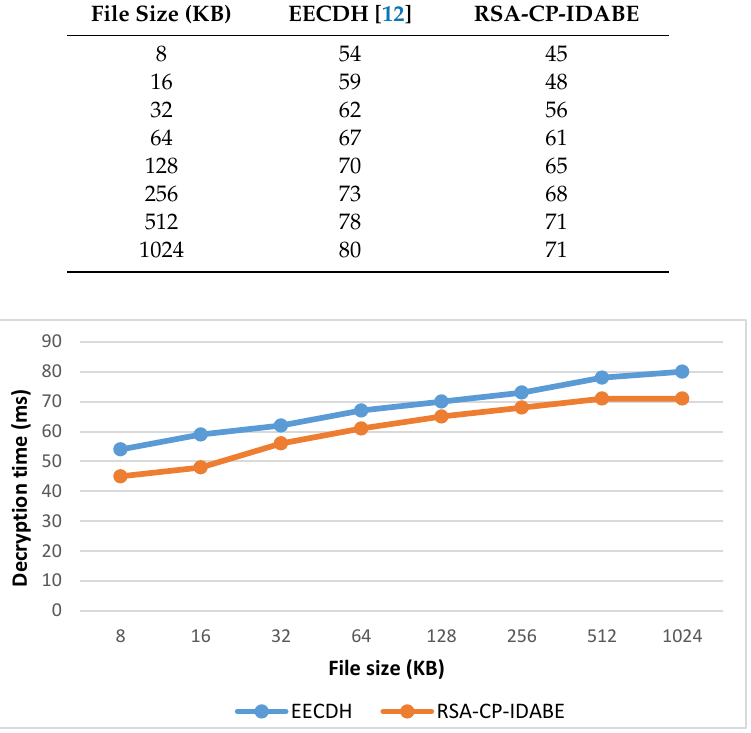
Figure 4. Comparison between the proposed RSA-CP-IDABE and EECDH for decryption time.